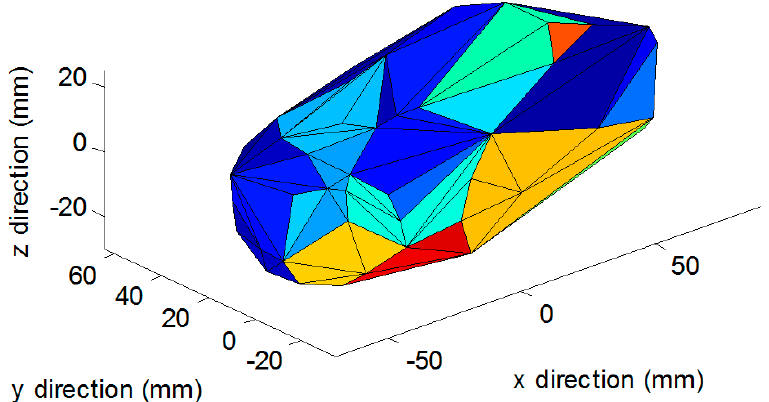
Figure 20. The 3D reconstructed image of the same mango, this time using the DDRS scanner. The 10% improvement is better seen in the 3D model when compared to the line laser scanner. The sides of the mango are detected and successfully reconstructed. The overall error of this mango compared to its actual volume is under 8%.